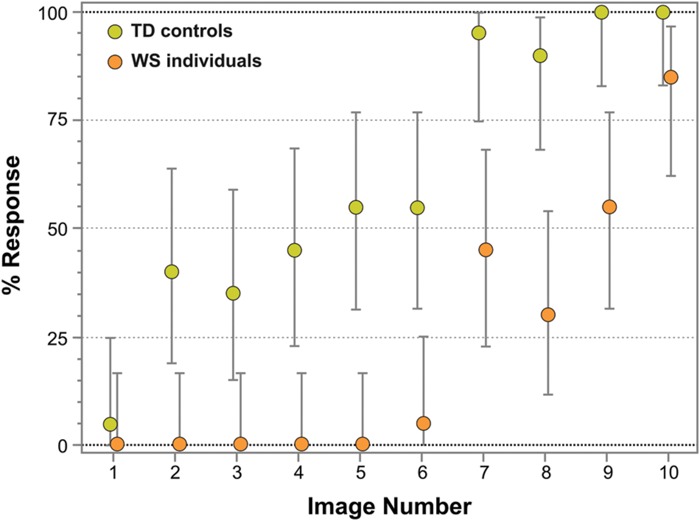
Percentage of face responses for WS and TD individuals. The image number reflects its face resemblance (1 – the least recognizable, 10 – the most recognizable as a face). WS individuals not only later report seeing a face and give much fewer face responses, but also later than TD controls reach a ceiling level of performance for their group. Vertical bars represent 95% CI.